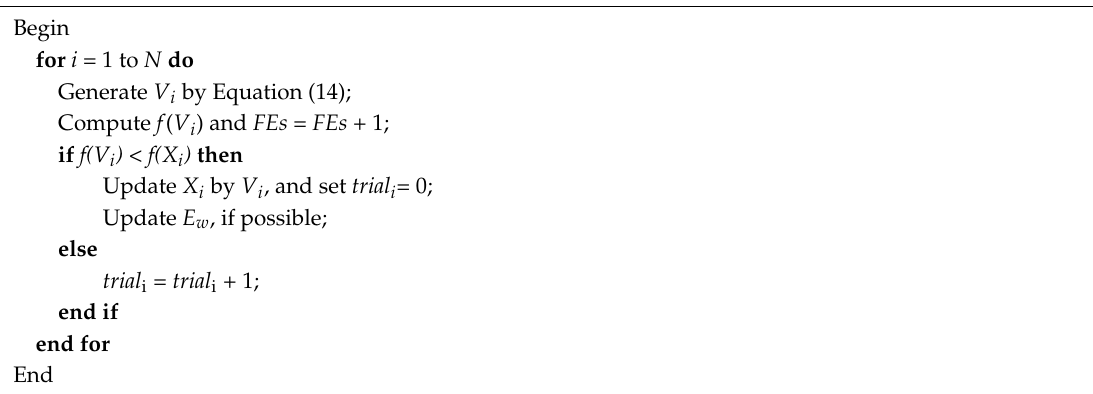
Algorithm 1: Framework of the Employed bee phase